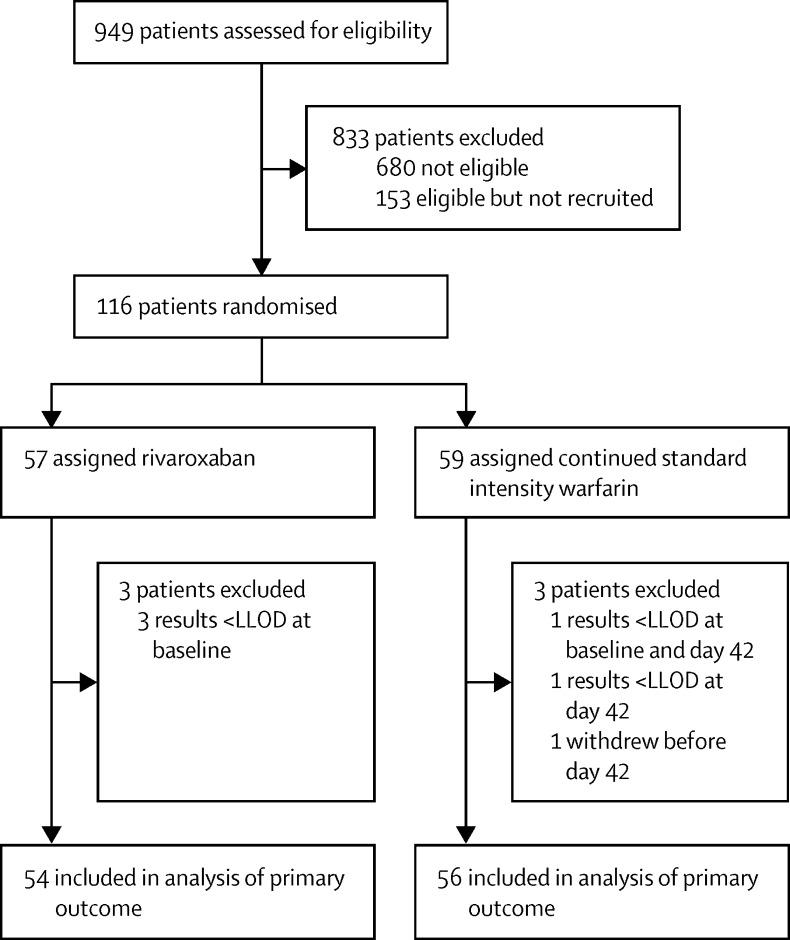
Trial profileLLOD=lower limit of detection.